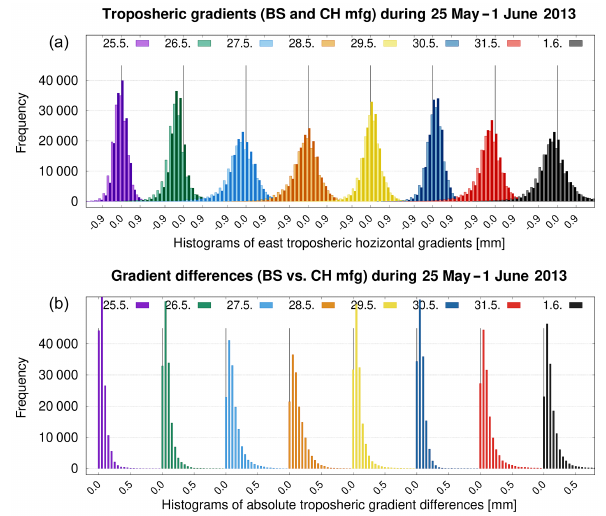
Figure 9. Eastern tropospheric horizontal gradients (a) estimated using Chen and Herring (light columns) and Bar-Sever (dark columns) mfg and the differences (b) in gradient magnitudes be- tween them. The SINEL2 OEW scheme was applied over 8 days in May/June